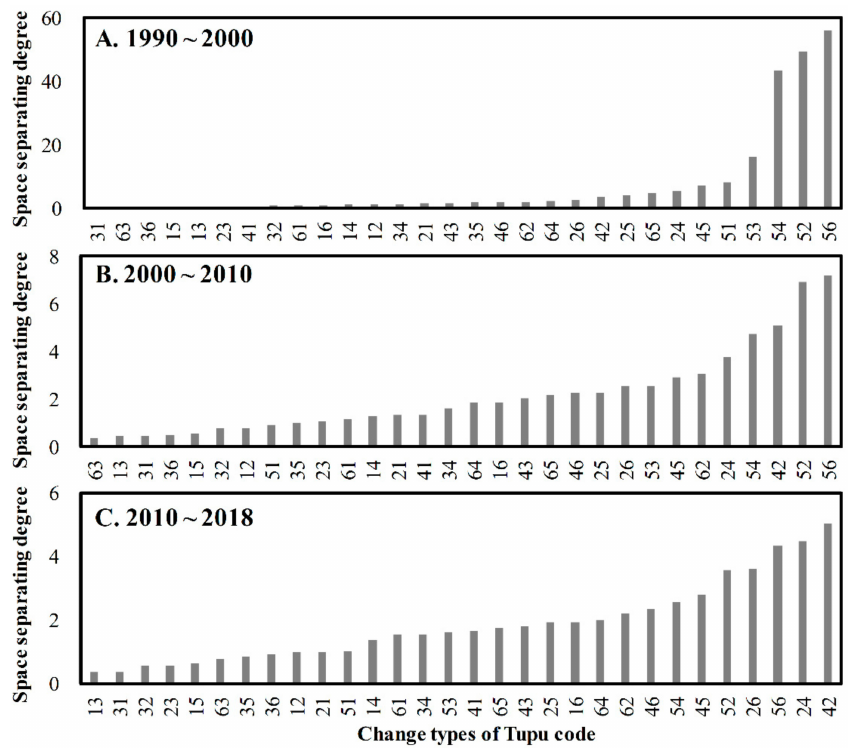
Figure 4. Spatial separation degree of Tupu units from 1990 to 2018 in the YRB. (Note: A , B and C denotes the spatial separation degree of Tupu units during 1990–2000, 2000–2010, and 2010–2018, respectively. No. 1–6 has the same meaning as Figure 3. The Tupu units’ codes can be seen in Table A1). (2) Spatial Distribution of Tupu Units from 2000 to